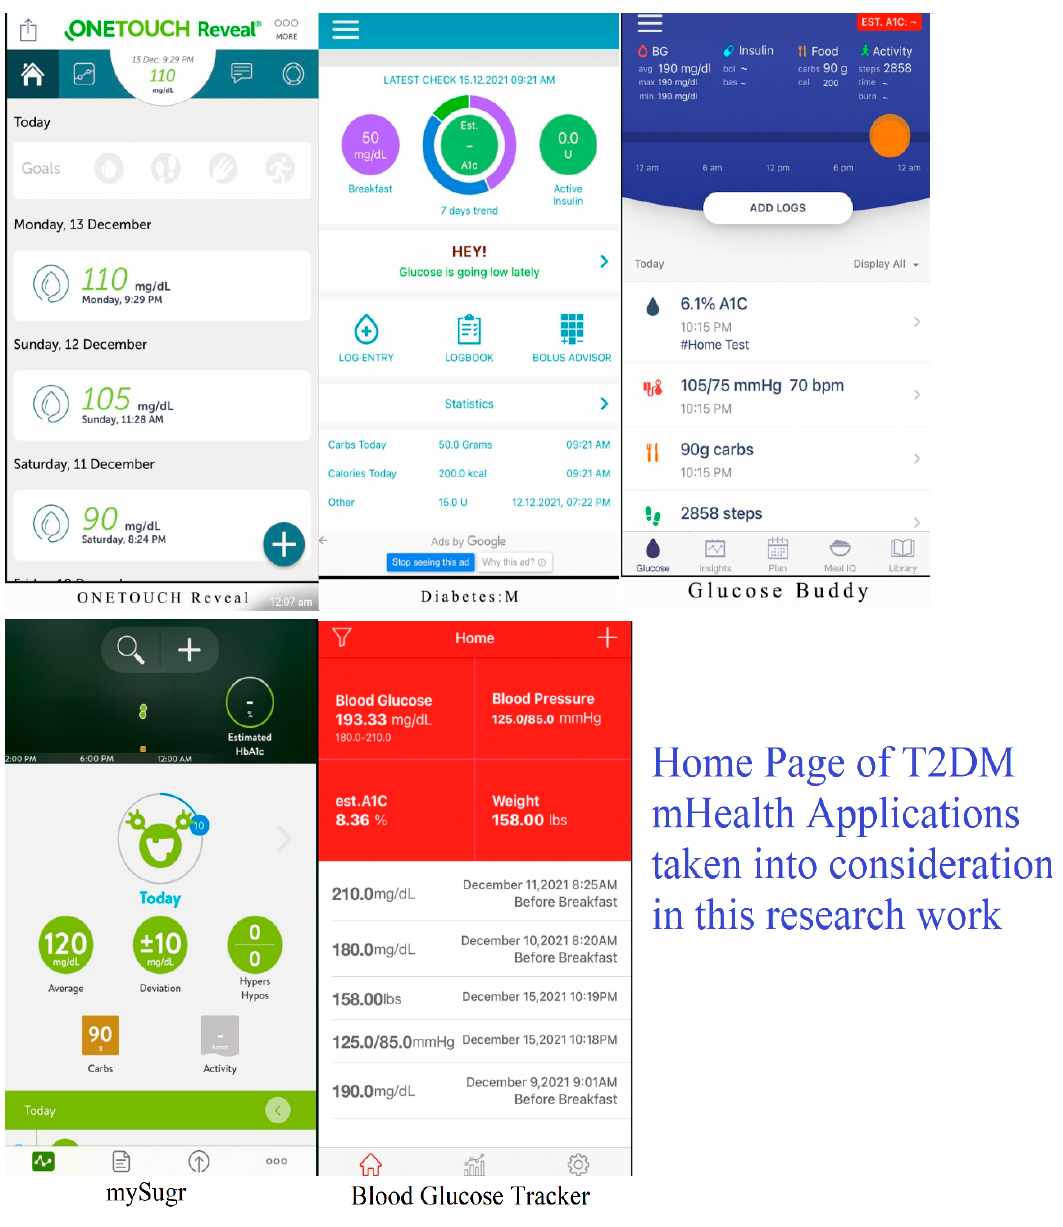
Figure 4. Screenshots of the homepage of the five T2DM mHealth applications taken into consideration.